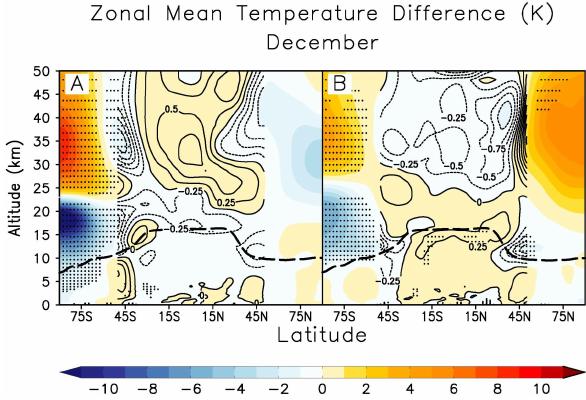
Figure 7: December zonal and monthly mean temperature differences (K) for experiment pair A (left) and experiment pair B (right). Isolines are used to provide structural information for the much smaller tropical changes. Negative differences are shown in cold colours and positive in warm colours. The black dashed line indicates the position of the tropopause in the base cases. Differences that exceed one standard deviation of the ‘Control’ are stippled.